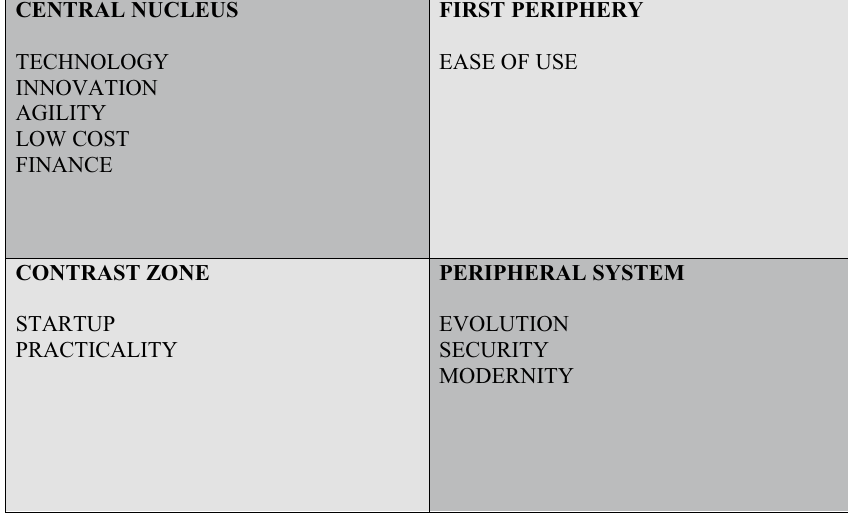
Fig. 4 Final social representation of